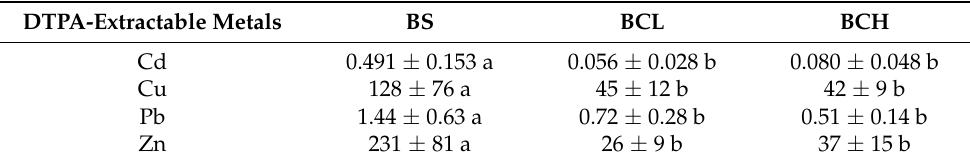
Table 6. DTPA-extractable concentrations (mg/kg) of Cd, Cu, Pb, and Zn in the biosolids and corresponding biochar samples. BS: biosolids, BCL: biochars prepared at low temperature,